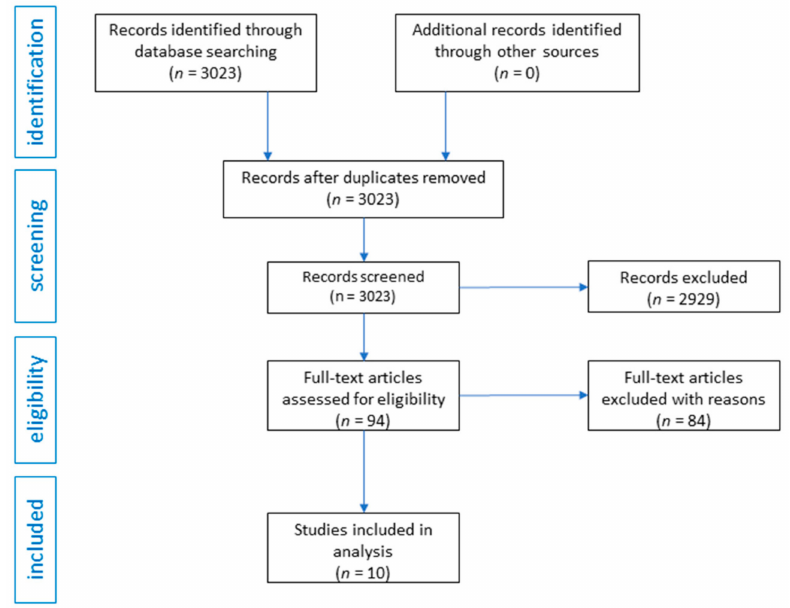
Figure 1. Flow diagram of systematic review of LSD, psilocybin and DMT in depression treatment.